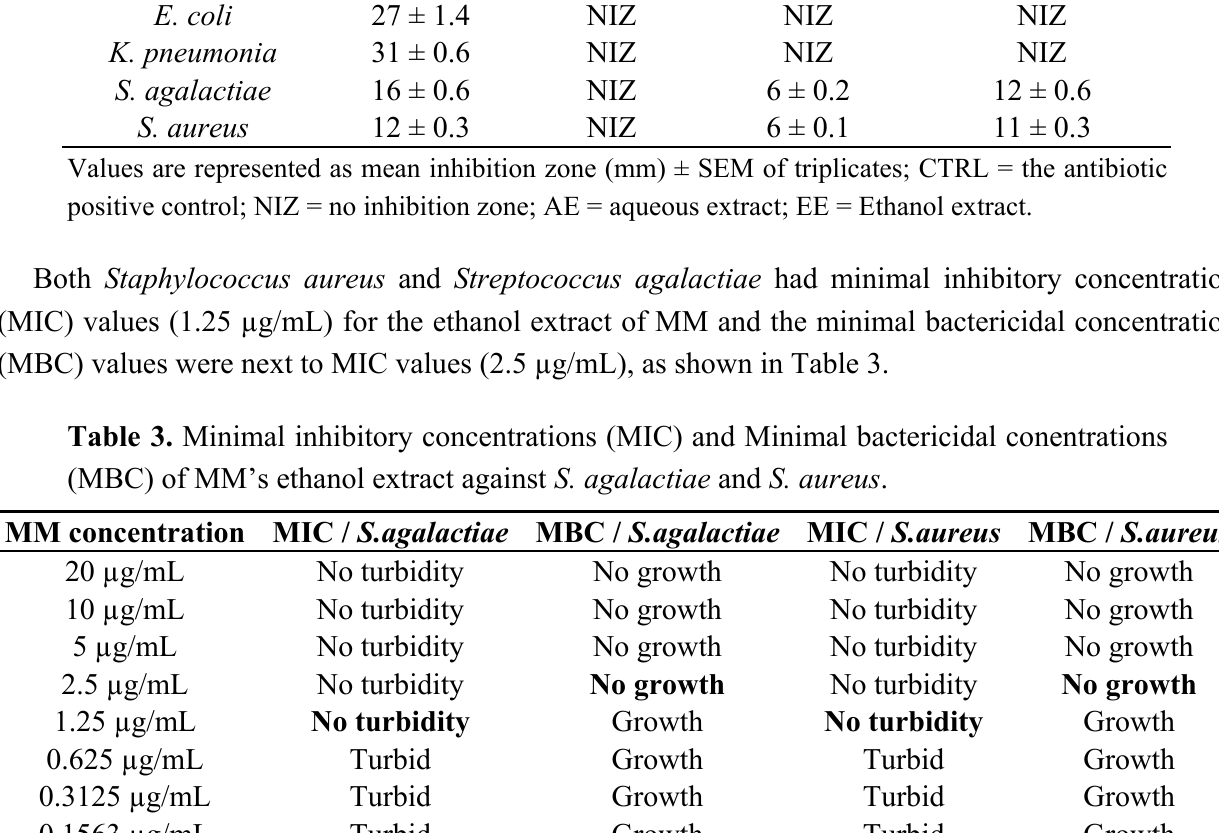
Table 2. MM’s antibacterial activity measured by the disc diffusion method. Bacterial species